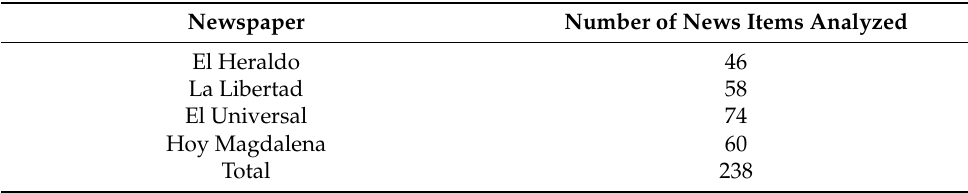
Table 2. Number of news items per newspaper (Source: Authors).